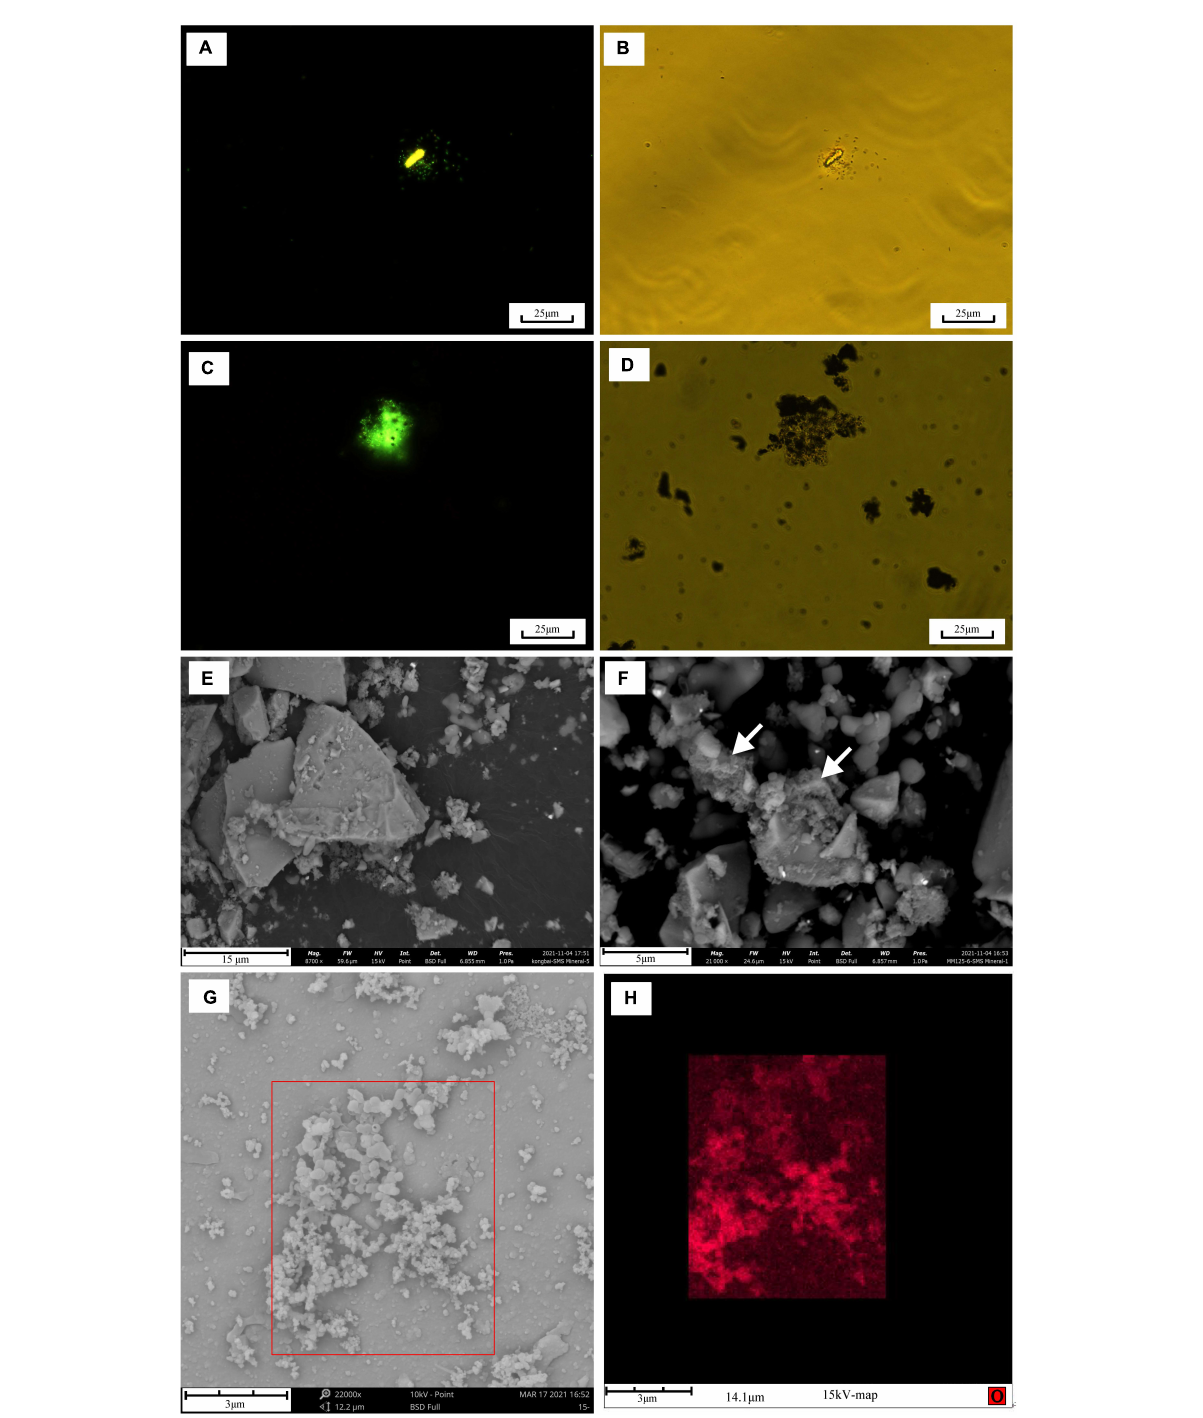
FIGURE6 Microscopy images of SYTO 9-stained cells grown in the presence of hydrothermal sulfide for 1 month in the modified MMJHS medium during and after the experiment and of morphology changes on the surface of hydrothermal sulfide. Fluorescent microscopy and corresponding brightfield images of incubation cells: (A,B) at day 5; (C,D) at 1 month. SEM images of hydrothermal sulfide morphology in abiotic (E) and biotic (F) experiment. In (F) cotton-like floes are visible on the surface (white arrows). SEM BSD image of biogenetic iron oxides on the surface of hydrothermal sulfides (G) and EDS map of oxygen element (H) corresponding to the boxed region of (G) . The operation parameters of SEM during observation are respectively shown at the bottom of the above SEM pictures. In (H) , oxygen in the particulate iron oxides appears in red against the background mineral (metal sulfide). Scale bars: (A–D) 25 µ m; (E) 15 µ m; (F) 5 µ m, and (G,H) 3 µ